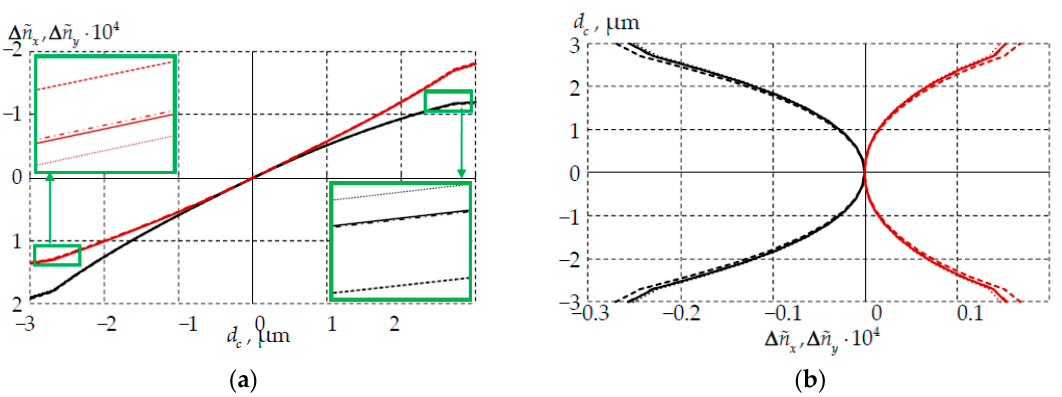
Figure 10. Change in refractive indices from the light-conductor core center: ( a ) slow axis; ( b ) fast axis; dash-dotted line is I zone of the thermal cycle; points is II zone; dotted line is III zone; solid line is VI; black is ∆ (cid:101) n x ; red is ∆ (cid:101) n y